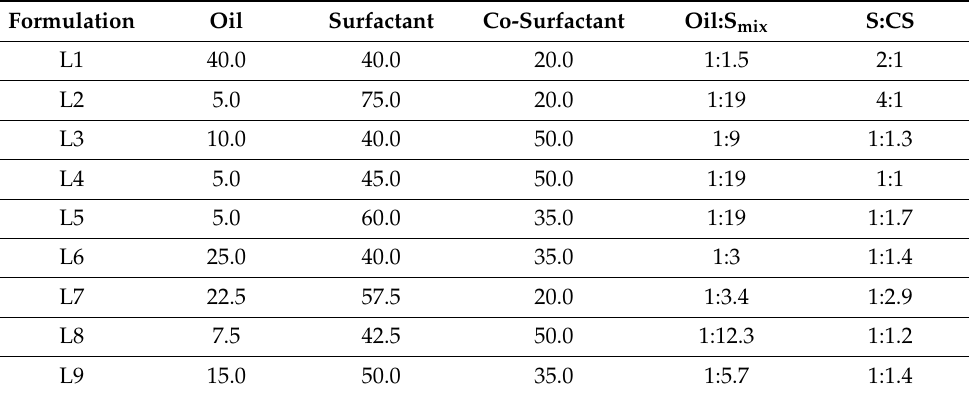
Table 2. Composition (%, w / w ) of liquid preconcentrates according to the mixture design experimen- tal layout.